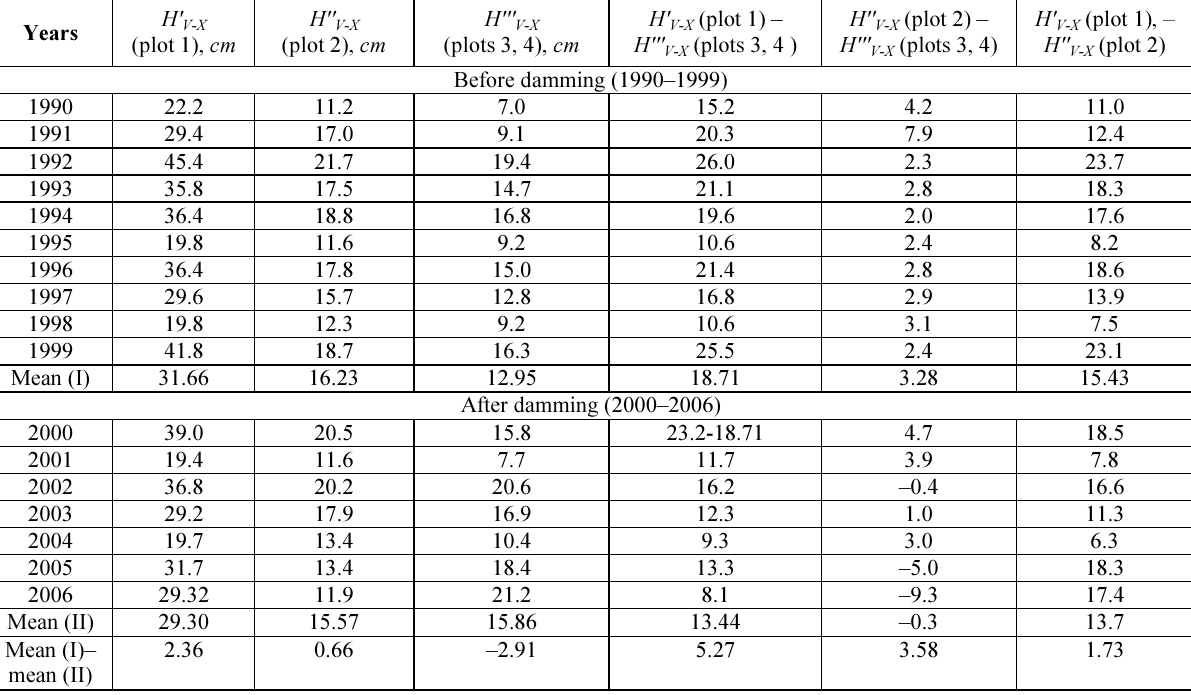
Table 2. The water table depth during the growth period (May to October) ( h V-X , given in cm) and the difference of water table depths before and after damming of the ditches (cm) given separately for the intensively (plot 1), extensively (plot 2) drained parts and undrained parts of the raised bog (control plots 3 and 4)